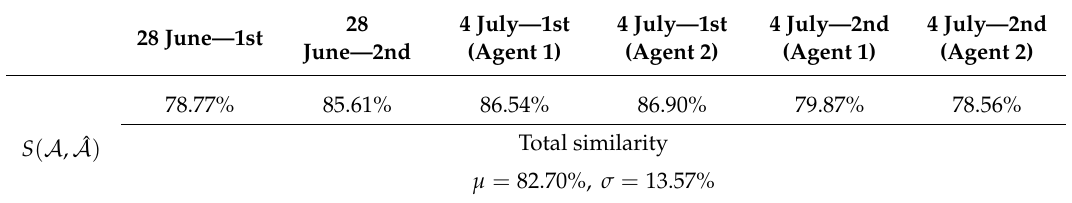
Figure 5. Dynamic time warping (DTW) results of synthetic agent traces compared to real-world agent traces (ground truth). Table 4. Similarity measure obtained from DTW for real-world agent traces and synthetic agent traces. The average cost of the optimal warping